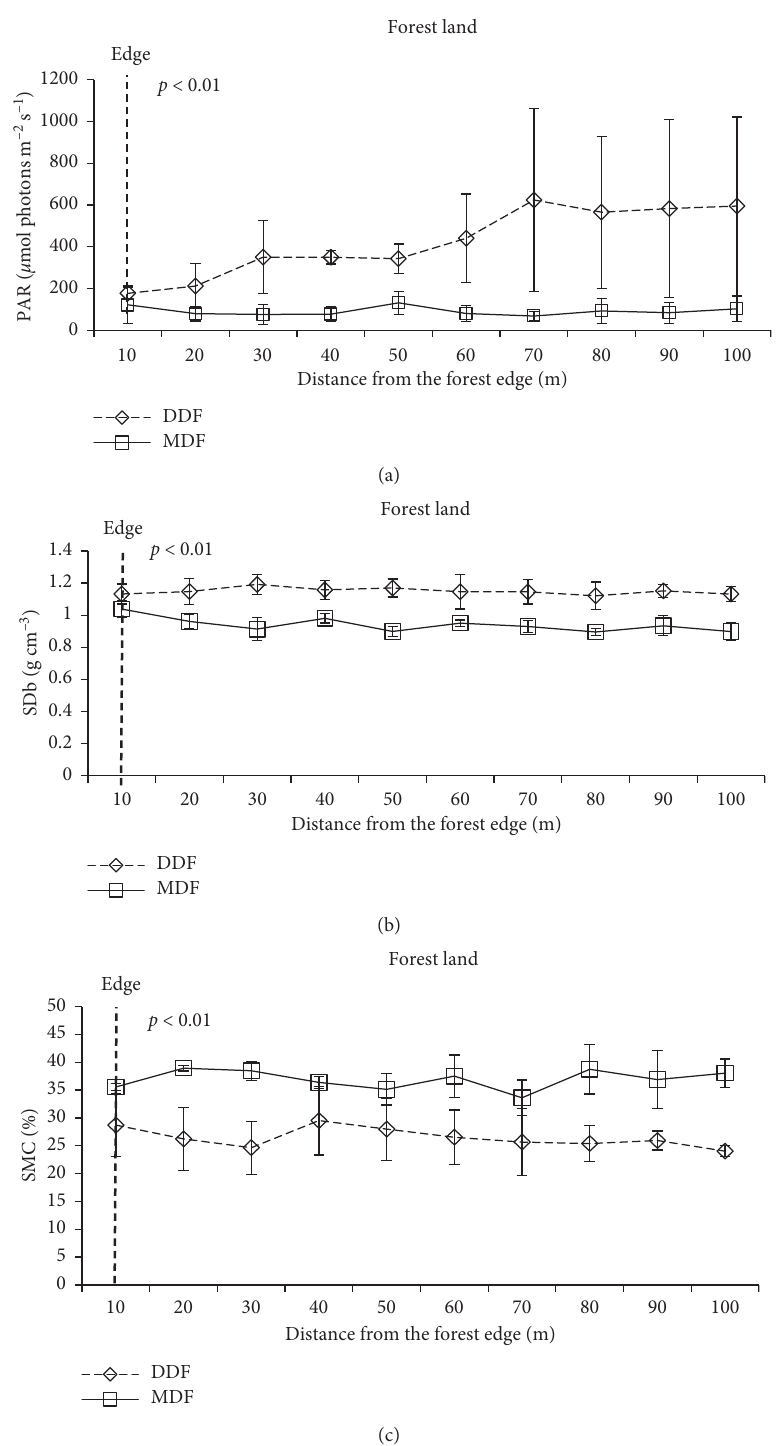
Figure 3: Changes in the physical environment from the edge to the interior of the forest study sites. (a) Photosynthetically active radiation (PAR) at 1.3m above the ground, (b) soil bulk density (SDb), and (c) soil moisture content (SMC) measured in DDF and MDF in the Mae Khum Mee subwatershed. Mean ± SD, n � 3 (for both the DDF and